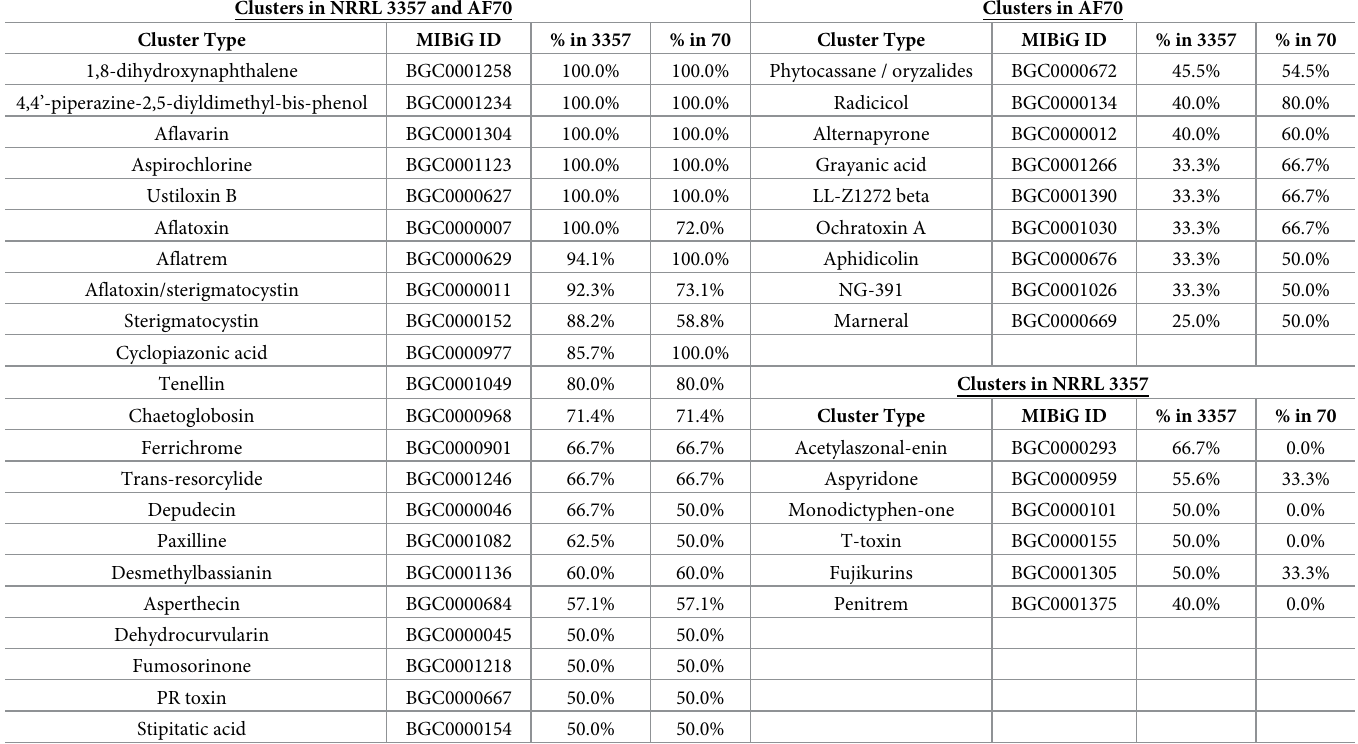
Table 2. Percentage of genes identified as being present in A . flavus strains AF70 and NRRL 3357 that are putatively involved in the production of the indicated toxin (cid:3) .